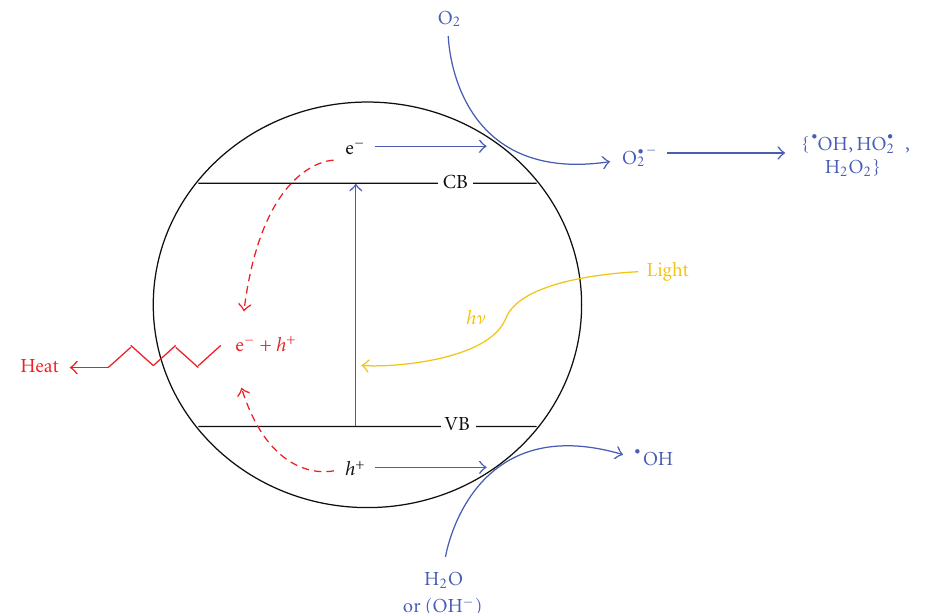
Figure 2: Schematic diagram illustrating the mechanism of photocatalysis on TiO 2